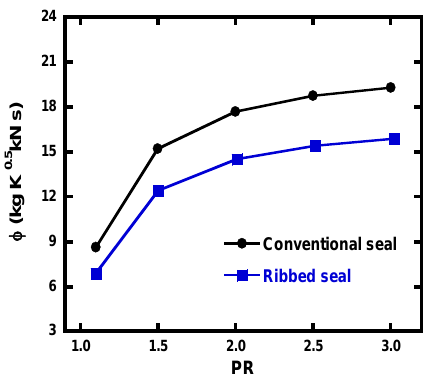
Figure 5. Variation in flow function of the conventional and ribbed seal with PR (S/H = 0.6, t/K = 0.1, β =